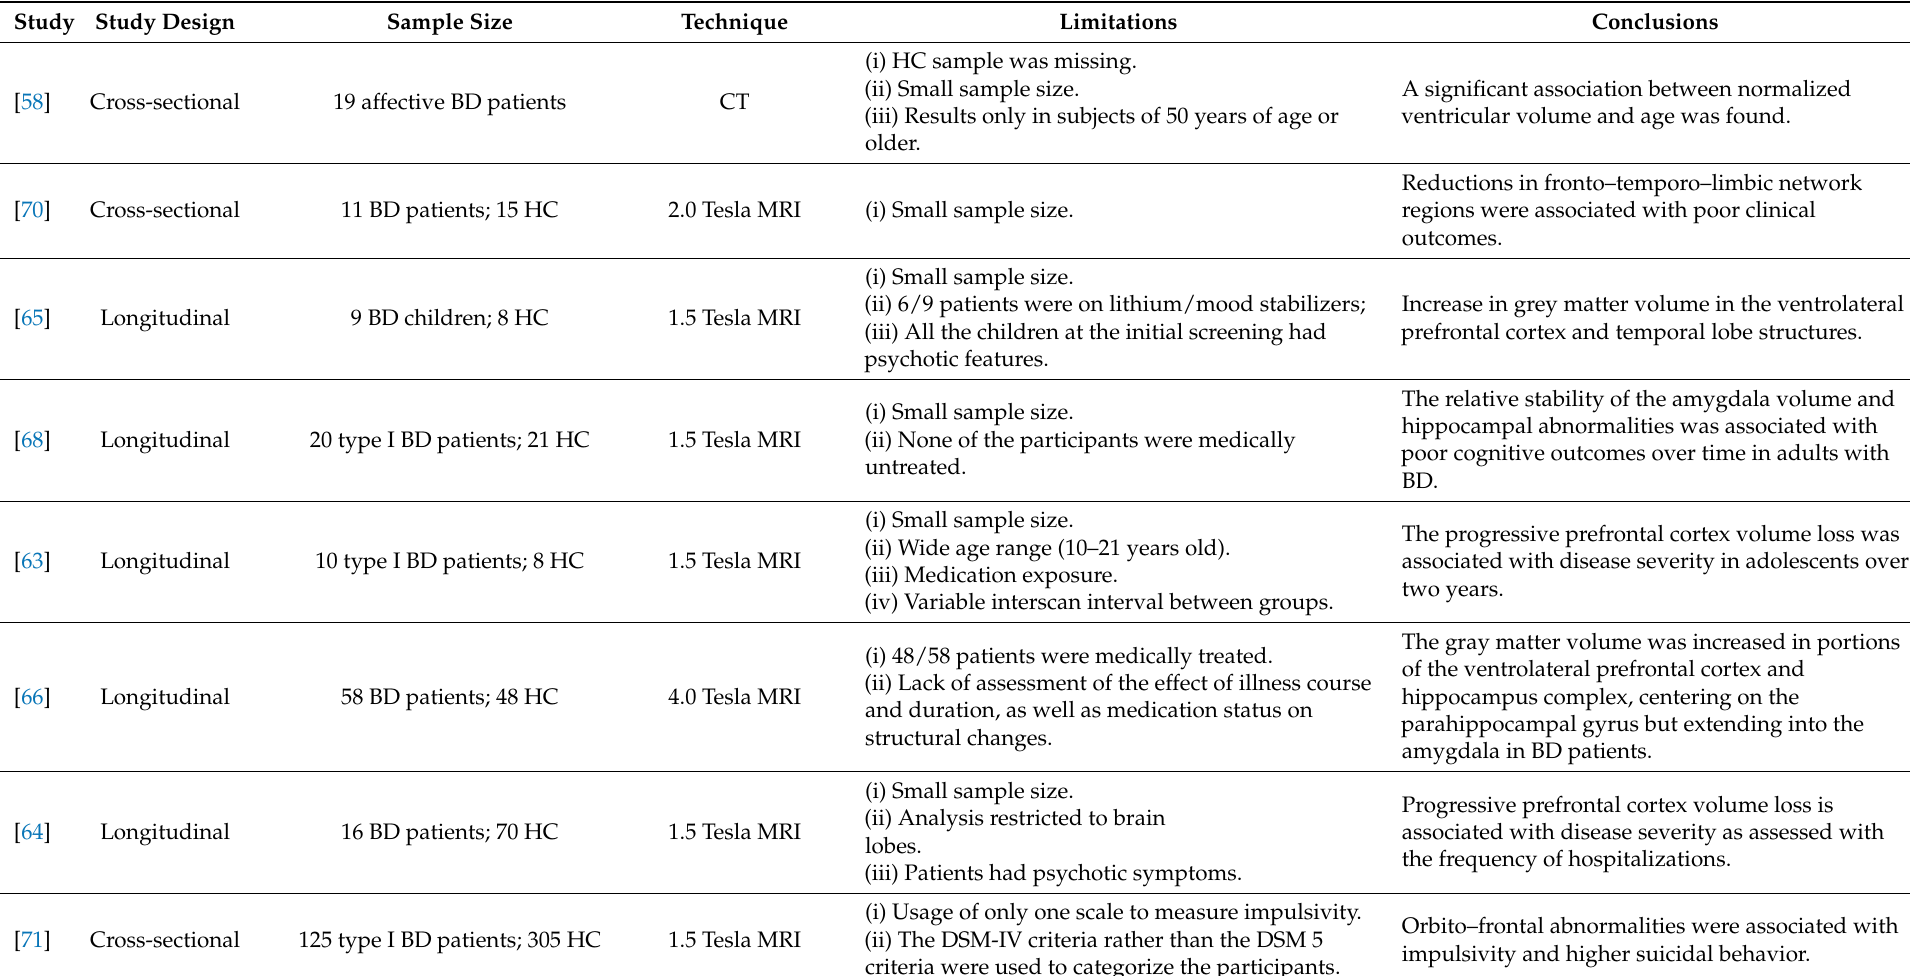
Table 2. The most relevant neuroimaging evidence concerning neuroprogression in